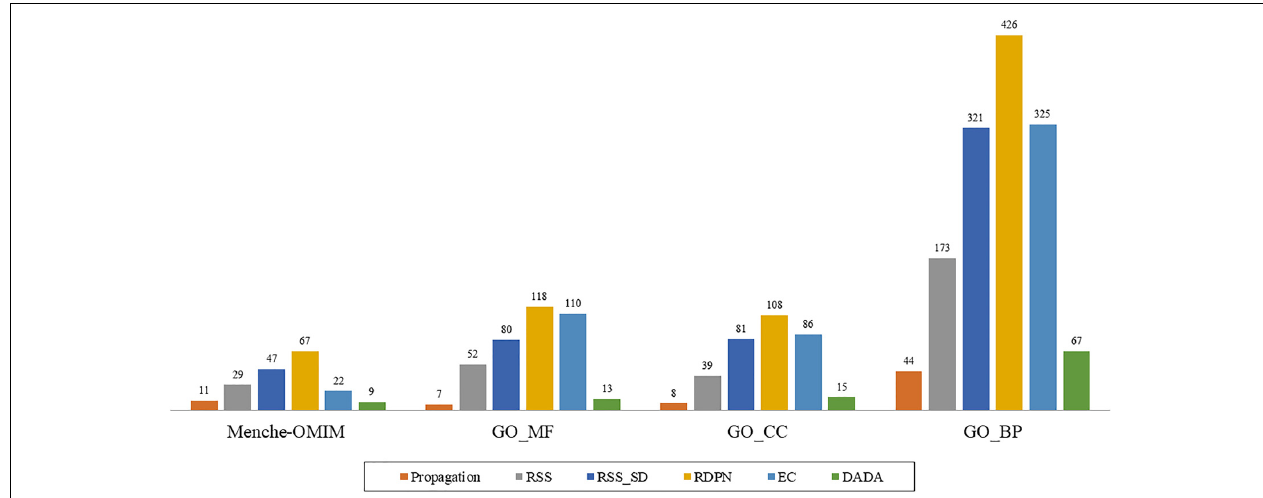
FIGURE 2 | “Best method” counts, based on the AUROC measure, of the six methods across four data sets: Menche-OMIM (173 diseases), GO-MF (358 terms), GO-CC (306 terms), and GO-BP (1237 terms).